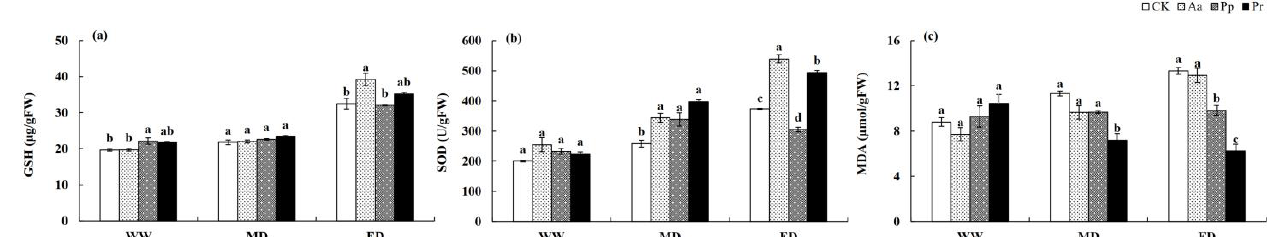
Figure 3. Influences of DSE on the antioxidant enzyme system of wheat leaves under three water treatments. ( a ) GSH, glutathione content. ( b ) SOD, superoxide dismutase. ( c ) MDA, malondialdehyde content. Different letters under a certain water condition indicate significant differences among the four DSE treatment groups ( p < 0.05). WW, well-watered. MD, mild drought stress. ED, severe drought stress.